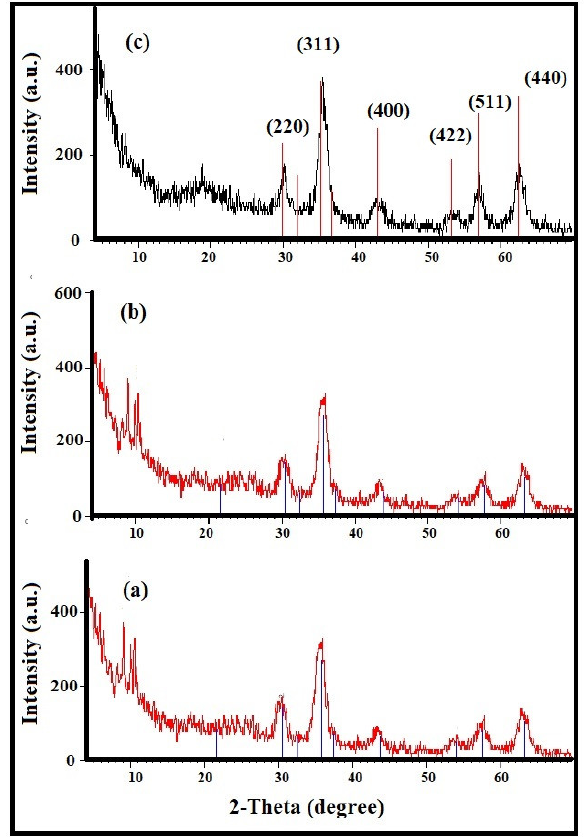
Figure 3. XRD diffractograms of ( a ) ELOA-Ag, ( b ) ELOA-Ag and ( c ) ELNA-Ag NPs. The particle size diameters of capped TiO 2 , Ag and Fe 3 O 4 NPs capped with EOA, ELOA and ELNA and their polydispersity index (PDI) were determined from DLS mea- surements in toluene and represented in Figure 4a–c, respectively. The particle sizes of TiO 2 (left Figure 4a–c) were increased from 20 nm to 89.4, 56.3 and 65.8 nm when